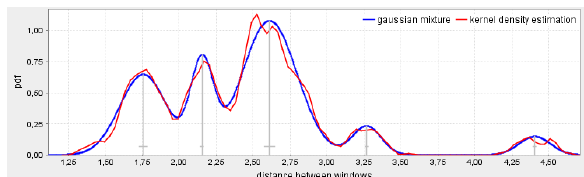
Figure 3: Gaussian mixture (blue) and kernel density estimation (red) for distance between two neighboring windows, mixture models good approximation with five means (gray vertical lines) and extremely small variances (gray horizontal lines). (Loch- Dehbi and Pl¨umer, 2015)